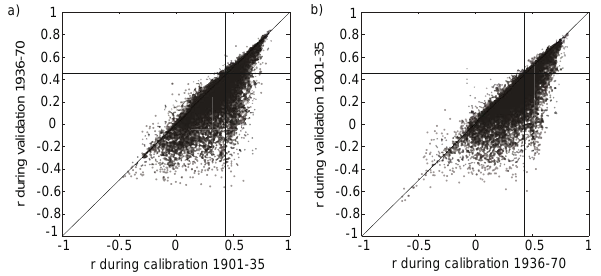
Fig. 6. Scatterplot of correlation coefficients between each ATRW VSL and ATRW ITRDB (200km search radius) series for the Fig. 6. Scatter plot of correlation coefficients between each ATRW VSL and ATRW ITRDB (200 km 12 1901–1935 and 1936–1970 independent time periods. Results are search radius) series for the 1901-1935 and 1936-1970 independent time periods. Results are 13 shown for (a) the early 1901–1935 calibration interval and (b) the shown for a) the early 1901-1935 calibration interval and b) the late 1936-1970 calibration 14 interval. 15 late 1936–1970 calibration